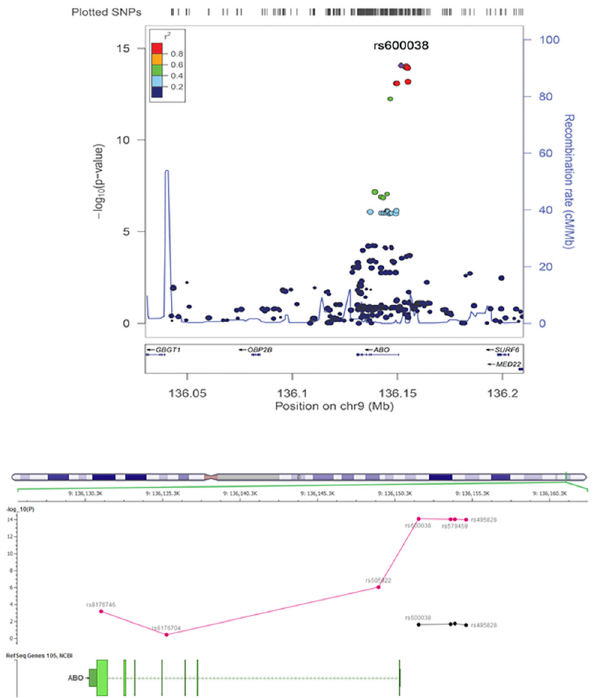
Fig 4. (A) The association signal between total serum ALP and the ABO blood locus. (B): The association of lead SNPs at the ABO locus with serum ALP and their relation with ABO tag SNPs (rs8176746, rs8176704, rs505922); A significant drop in association effect in lead SNPs after controlling for ABO-tag SNPs are shown (red and black dots represent before and after conditional analyses